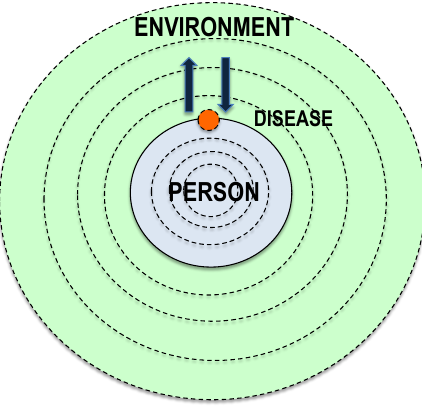
Figure 1. Guiding model of the inner and outer complexity of the human-in-the-world (integrative onion-shell model), which understands diseases and/or disorders (e.g., addiction) as a consequence of inconsistencies in the external and/or internal relationship structure of this system [32].